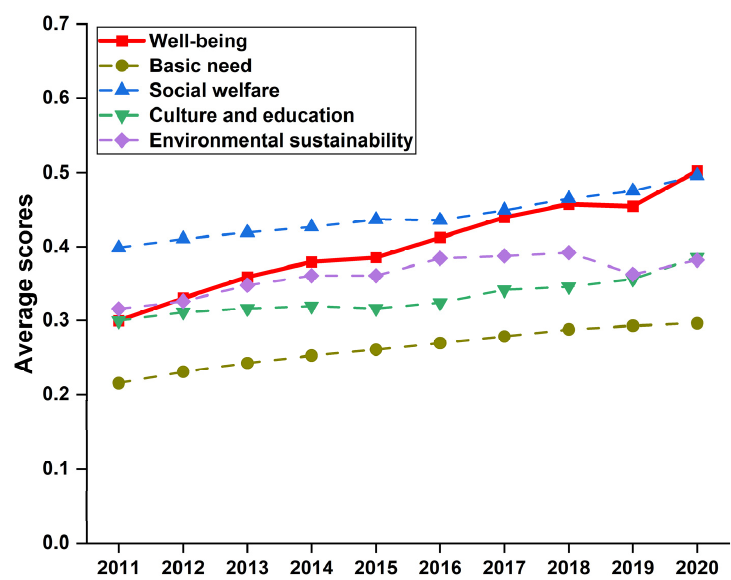
Figure 1. Trend of scores of four subsystems and well-being from 2011 to 2020.